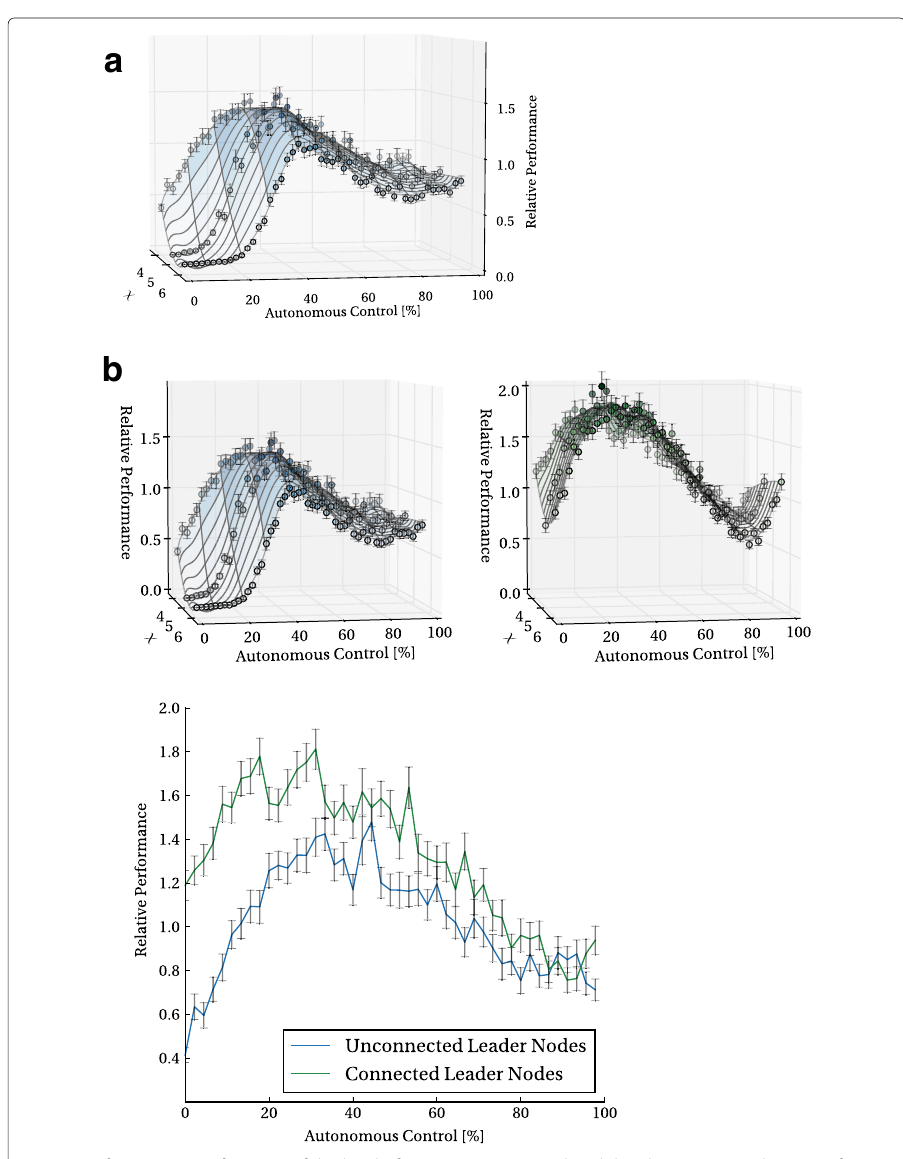
Fig. 2 Performance as a function of the level of autonomous control and the chromatic number χ ( a ) for unconnected leader nodes, ( b ) comparison between connected and unconnected leader nodes for χ = 4